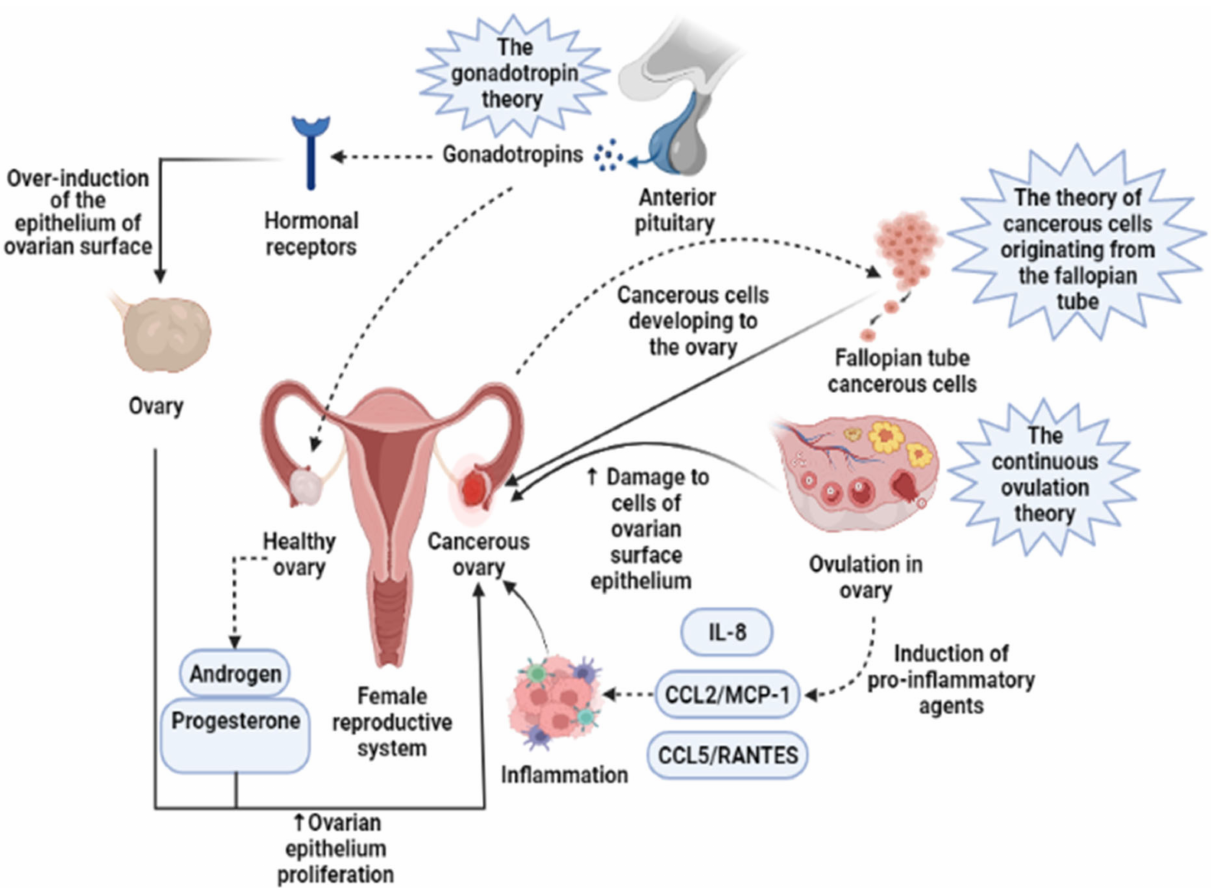
Figure 1. Three main theories regarding the development of ovarian cancer are based on induction of the epithelium of ovarian surface by hormonal receptors, increased induction of pro-inflammatory agents during continuous ovulation, and cancerous cells originating from the fallopian tube. IL-8, Interleukin-8; CCL2/MCP-1, Monocyte chemoattractant protein-1; CCL5/RANTES, CC Chemokine